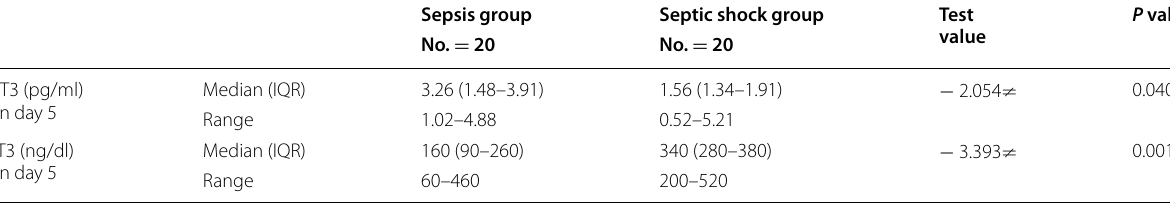
Table 3 Comparison between sepsis and septic shock regarding the thyroid hormones in day 5